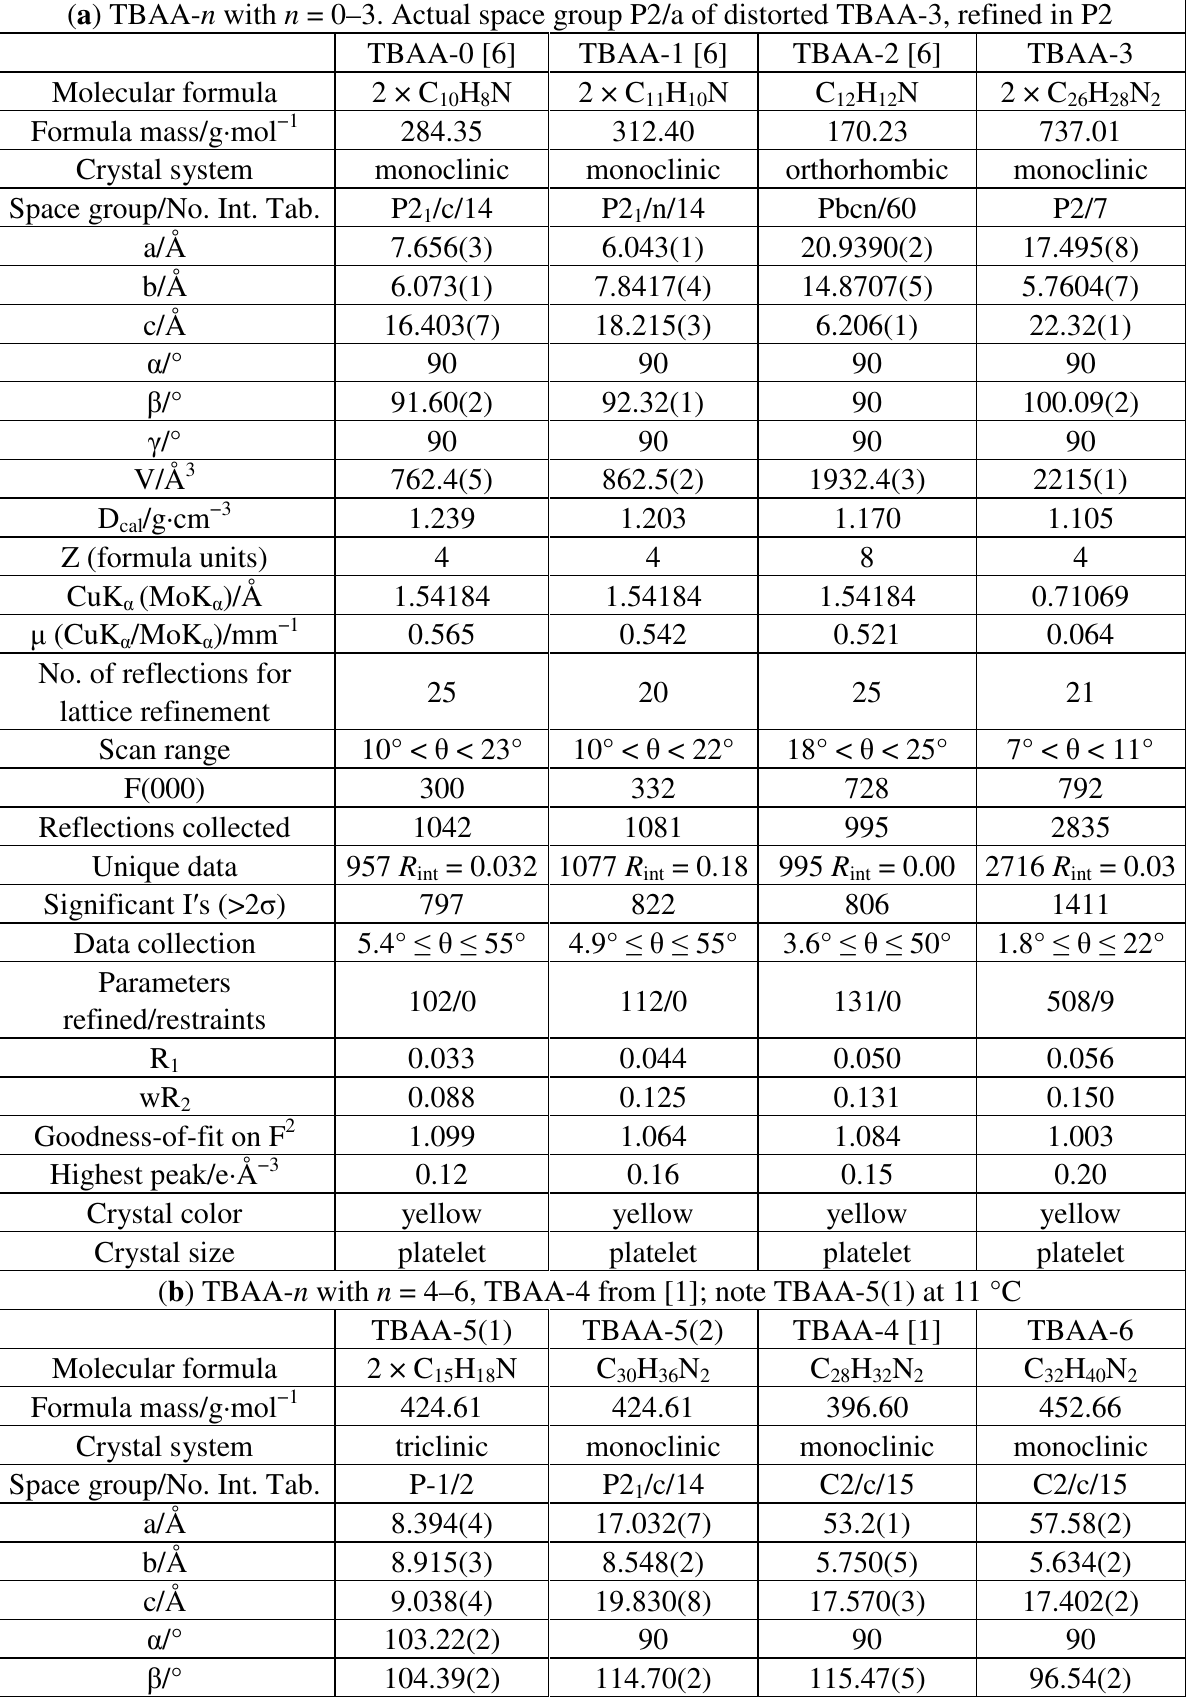
Table 8. Summary of crystallographic data of TBAA- n collected at ambient